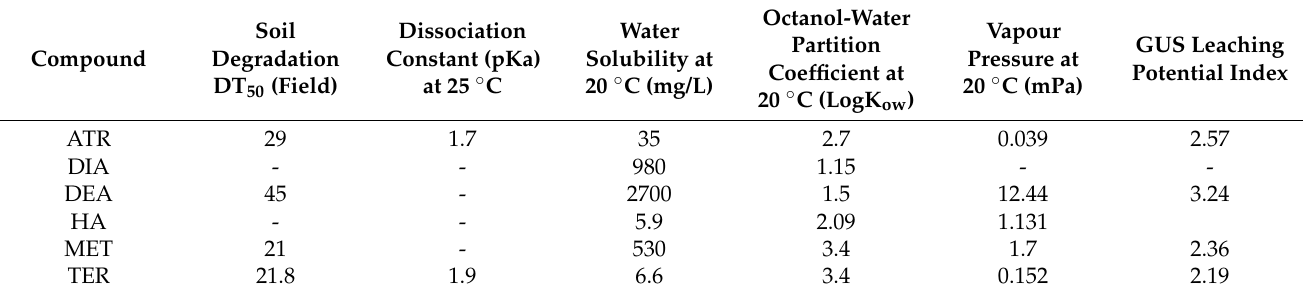
Table 1. Physicochemical properties of target compounds